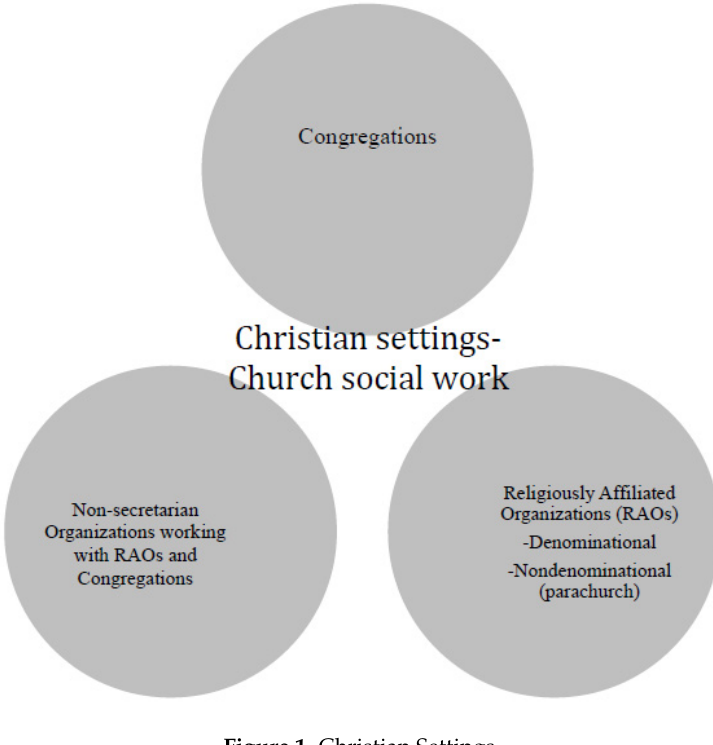
Figure 1. Christian Settings.